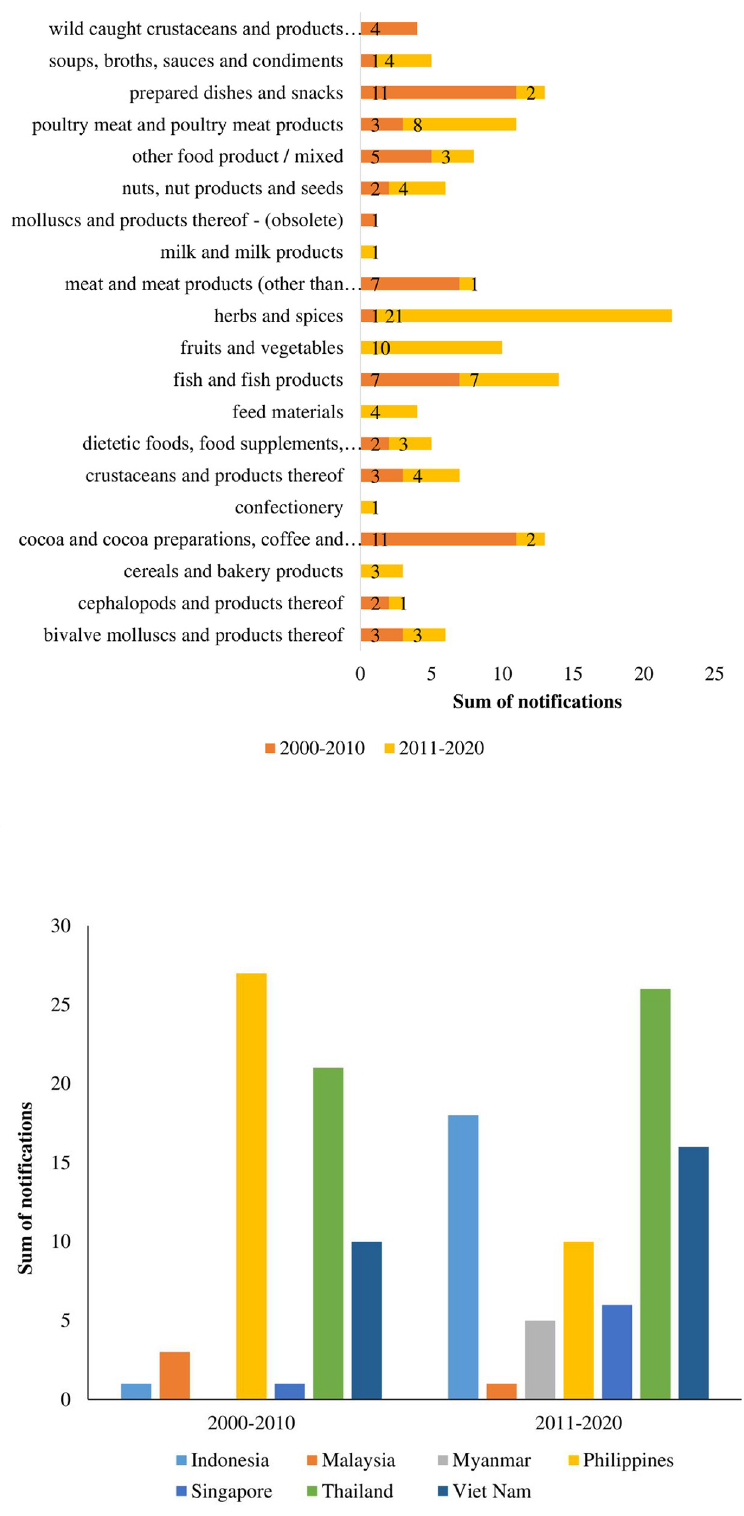
Fig 4. a. Distribution of food fraud notifications in RASFF by decade and by product category (2000 and 2020). b. Distribution of food fraud notifications in RASFF by decade and by country (2000 and 2020).